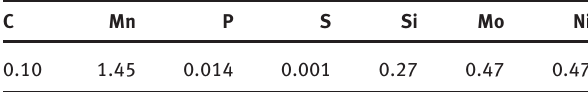
Table 1: Chemical composition of SA302Gr.C (wt %).